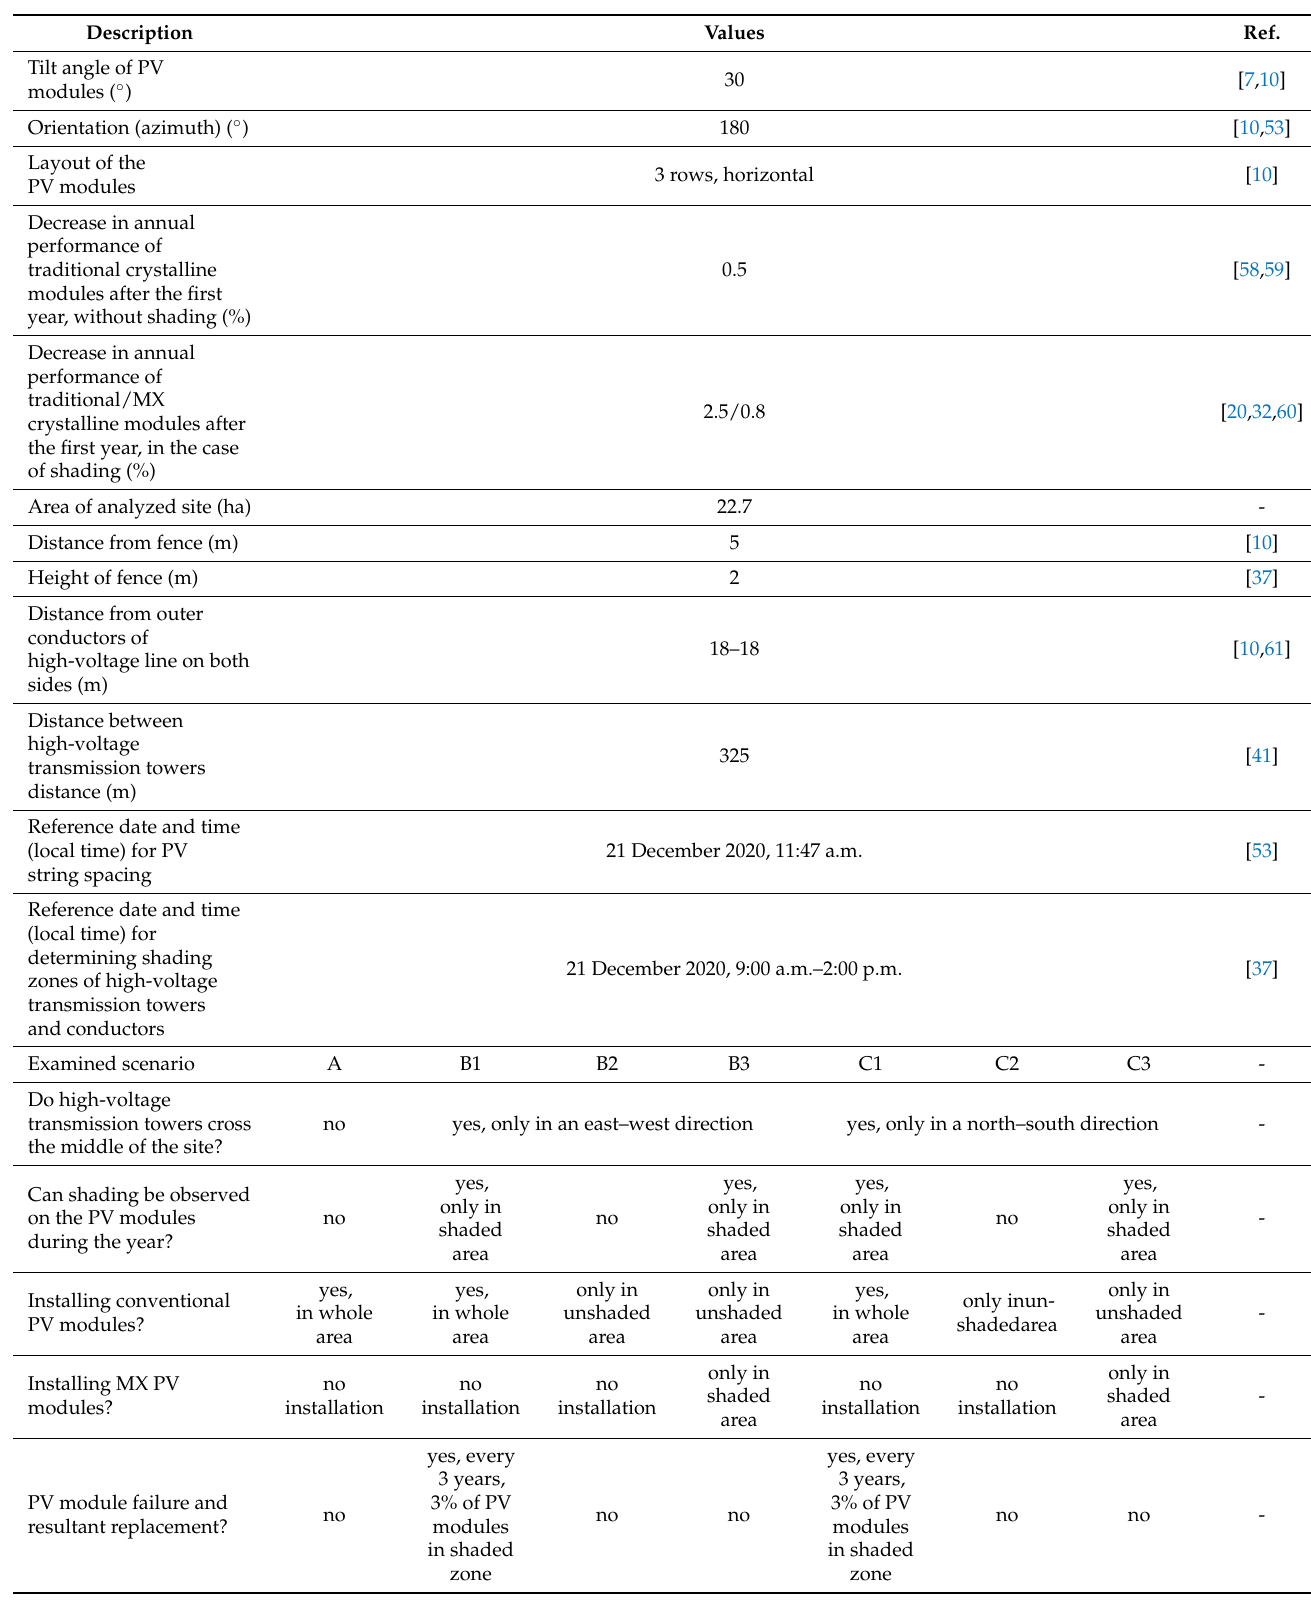
Table 1. The description of the main aspects of the